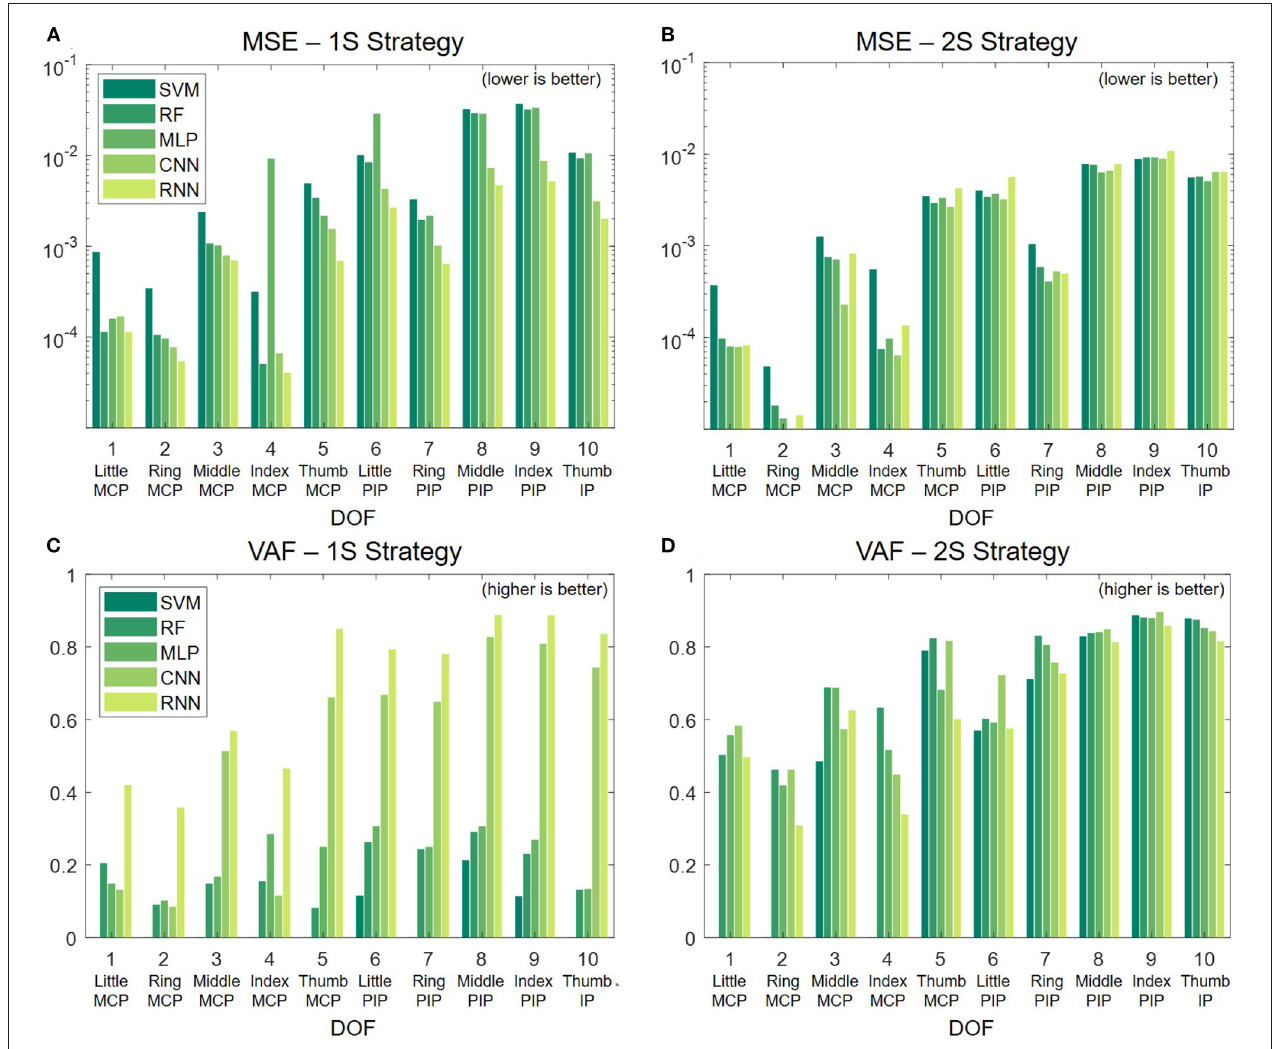
FIGURE 7 | Regression performance in term of MSE (A,B) and VAF (C,D)